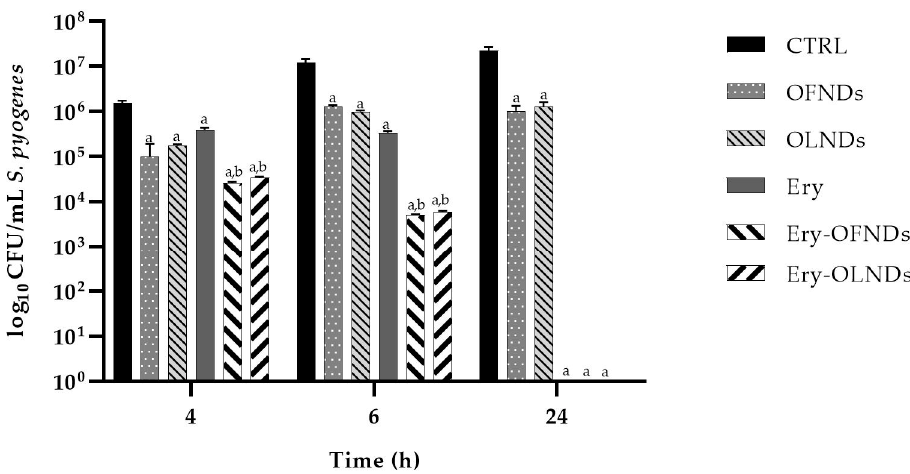
Figure 5. Anti- S. pyogenes activity of OFND or OLND formulations, expressed as Log 10 CFUs/mL, loaded or not with erythromycin. vs. control: a p < 0.0001 ; vs. Ery: b p < 0.001 .